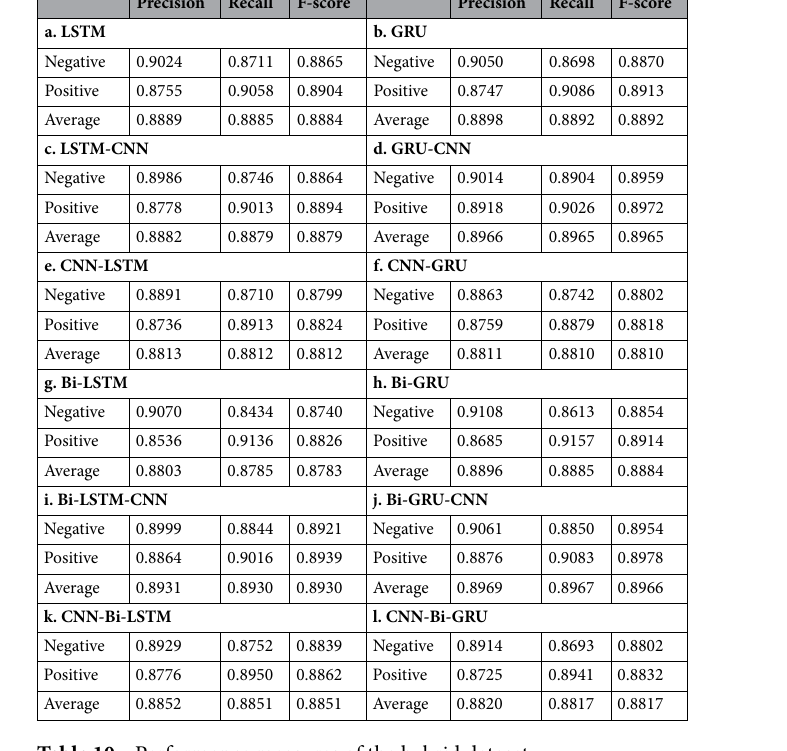
Table 10. Performance measures of the hybrid